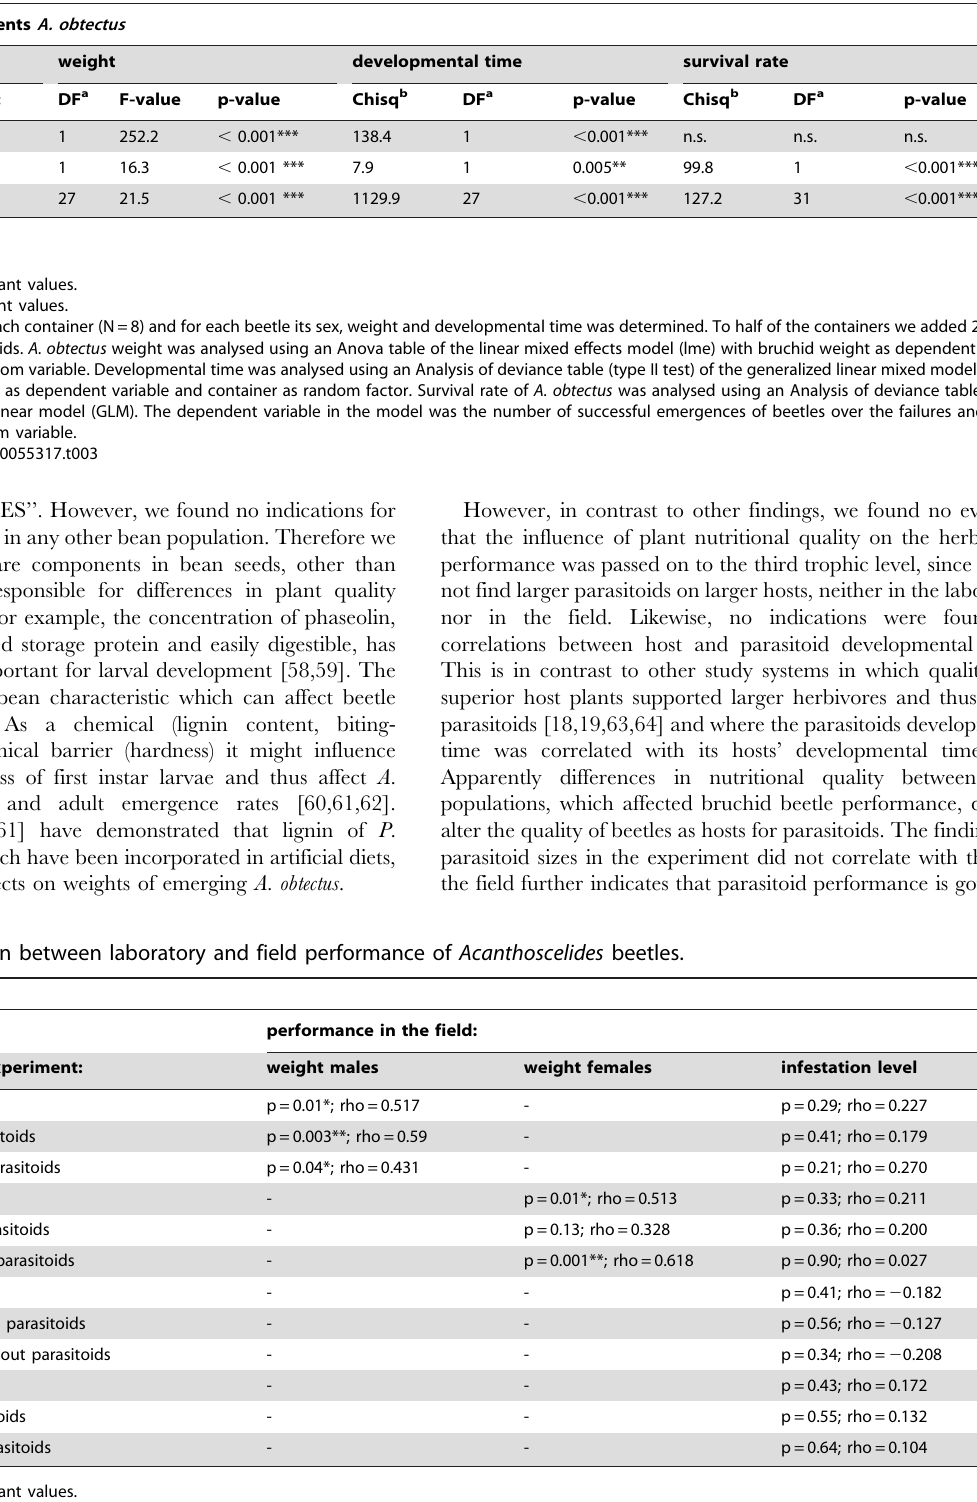
performance experiments A.obtectus